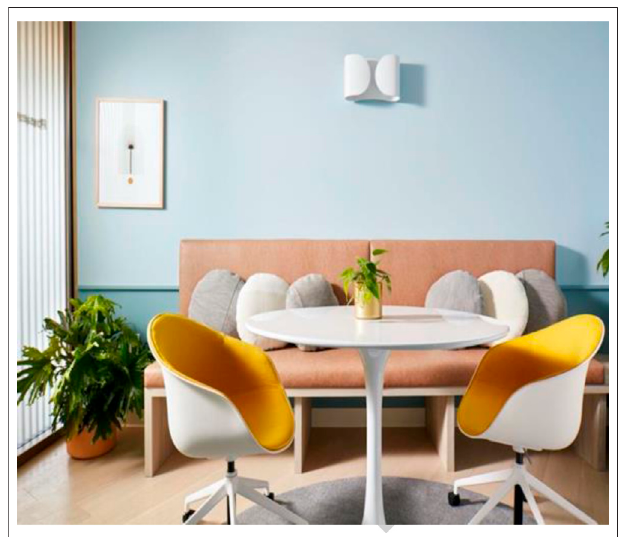
FIGURE 2 | Waiting area: Credit Kara Ladd, Architectural Digest (2019), photography by Trevor